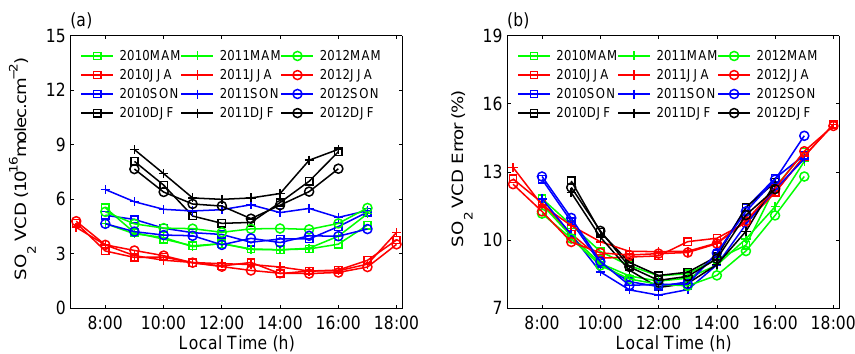
Figure 15. (a) Seasonally averaged SO 2 VCD diurnal cycles and (b) corresponding errors. Data points represent hourly means.